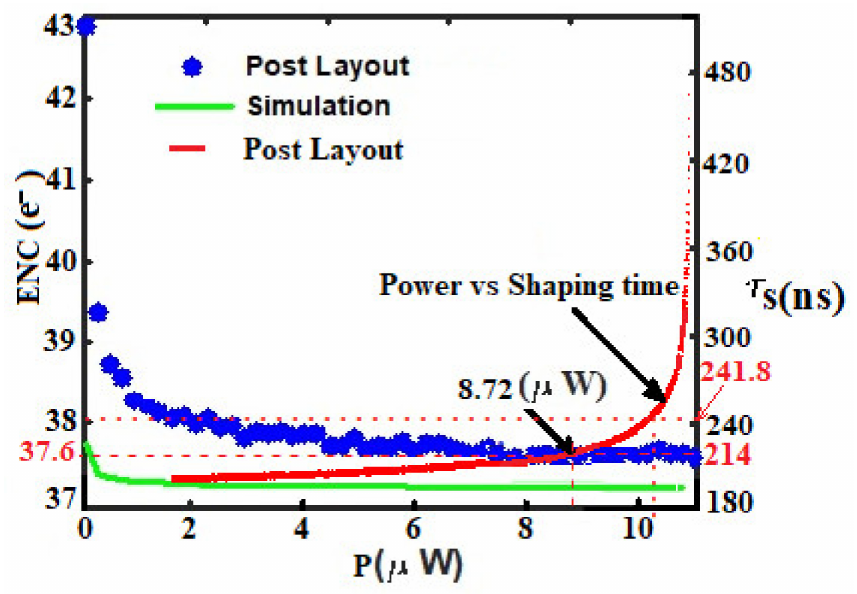
Figure 19. Validation of the design performance in terms of ENC, power consumption, and shaping time.